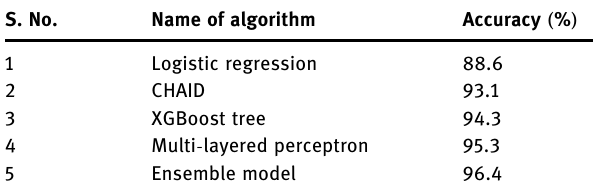
Table 6: Accuracy comparison S.